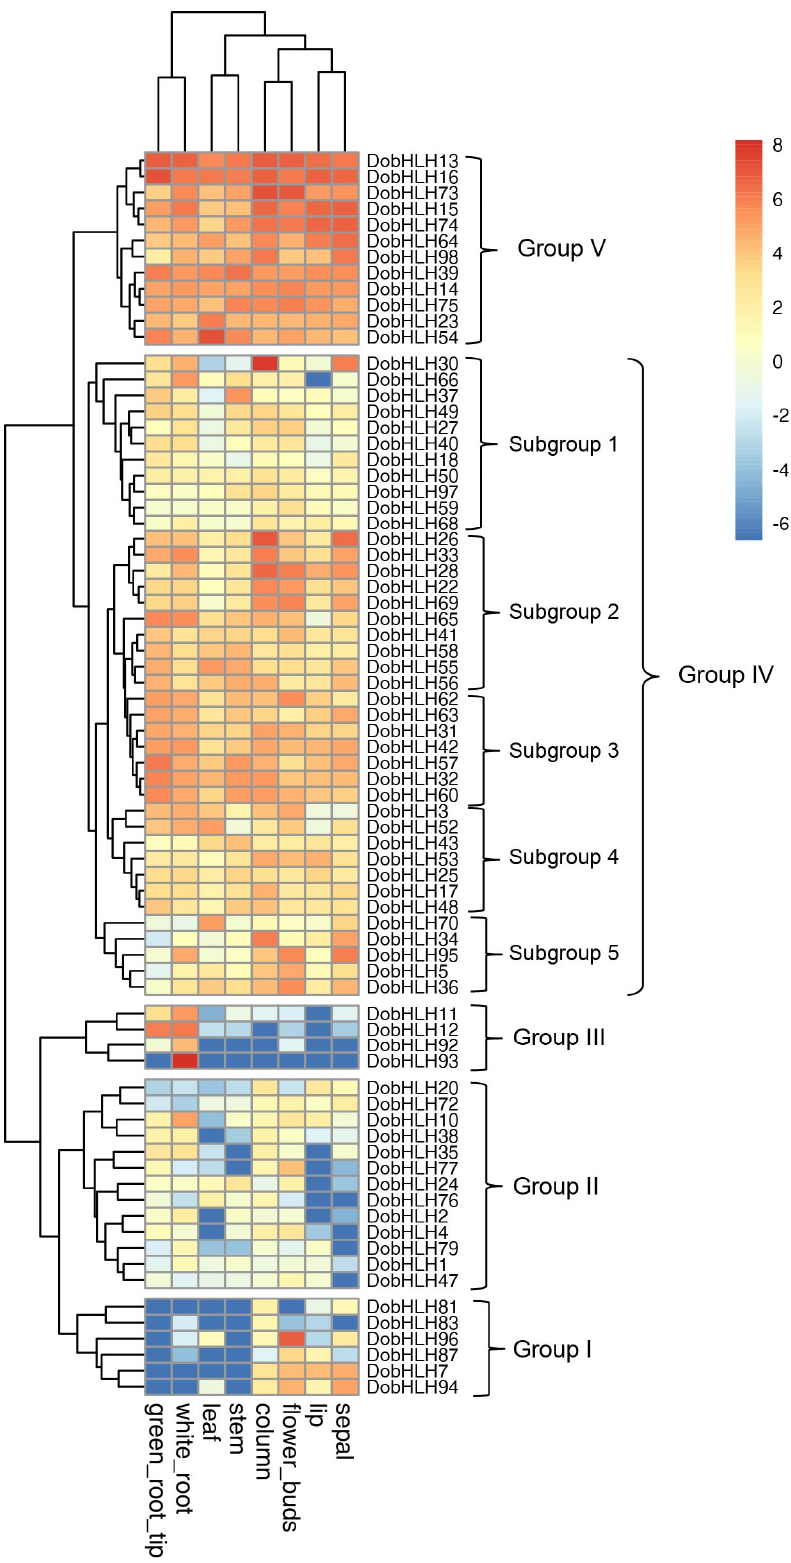
Figure 5. Expression patterns of 75 DobHLH genes in eight tissues. The expression levels of 75 DobHLH genes were from the RNA-Seq data. The eight samples included the column, flower buds, lip, sepal, leaf, stem, white root and green root tip. The color scale represents the values of Log 2 (FPKM + 0.01).